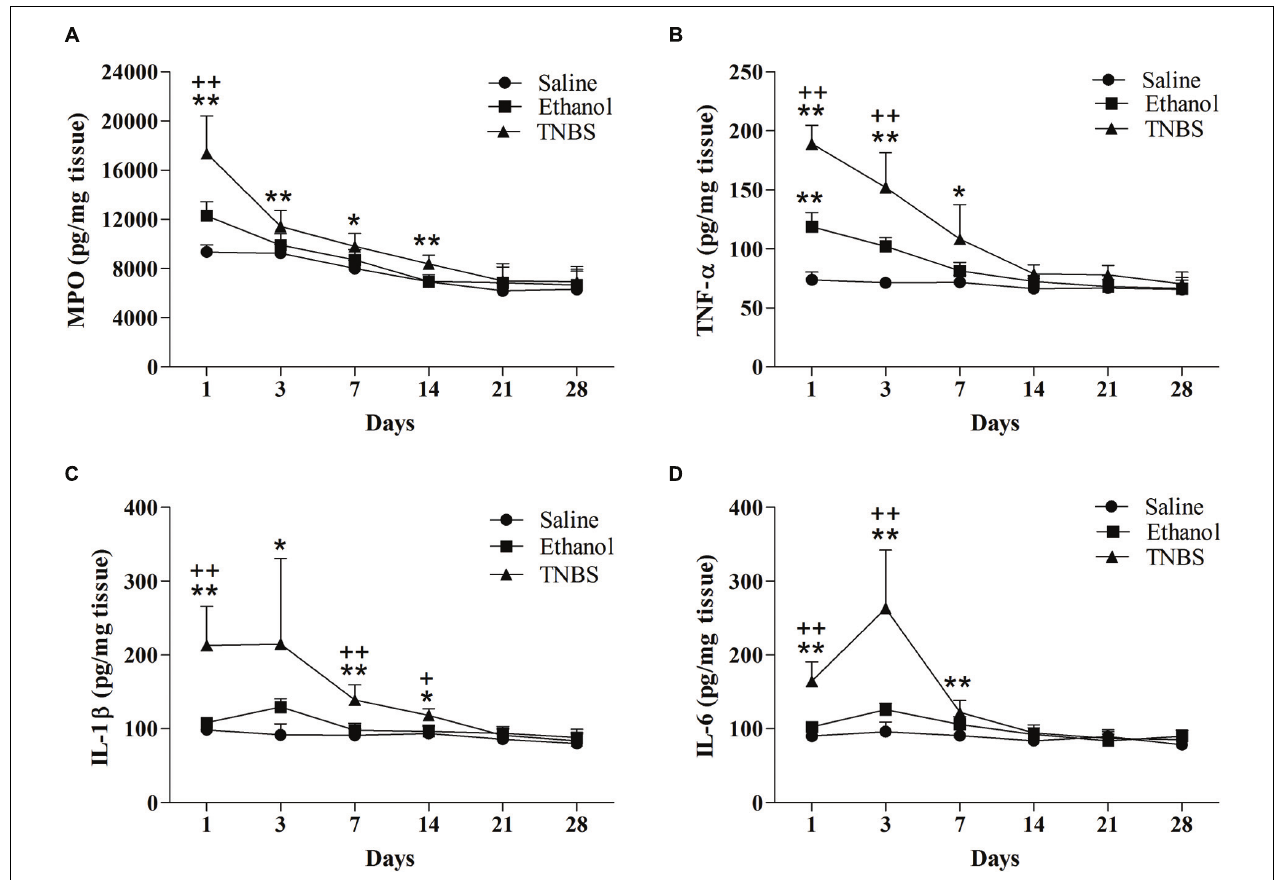
FIGURE 5 | Effects of TNBS administration on the levels of MPO (A), TNF- α (B), IL-1 β (C), and IL-6 (D) in the ileal tissue of the rats. ∗∗ P < 0.01, ∗ P < 0.05; TNBS group/Ethanol group vs. Saline group. ++ P < 0.01, + P < 0.05; TNBS group vs. Ethanol group. (TNBS vs. Ethanol/Saline group; One-way ANOVA followed by Dunnett’s T3 post-test) (Ethanol group vs. Saline group; One-way ANOVA followed by Bonferroni’s